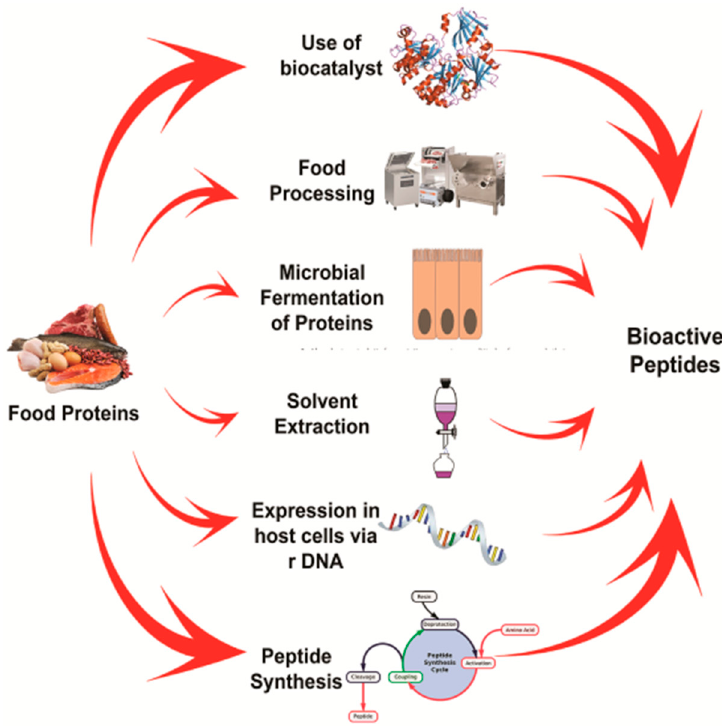
Figure 7. Production of bioactive peptides based on the enzymatic hydrolysis (using proteolytic enzymes from either plants or microbes), hydrolysis with digestive enzymes (simulated gastrointestinal digestion), by fermentation using starter cultures, solvent extraction based on the precipitation of the proteins, triggering the overexpression of the peptide based on stress mechanism .